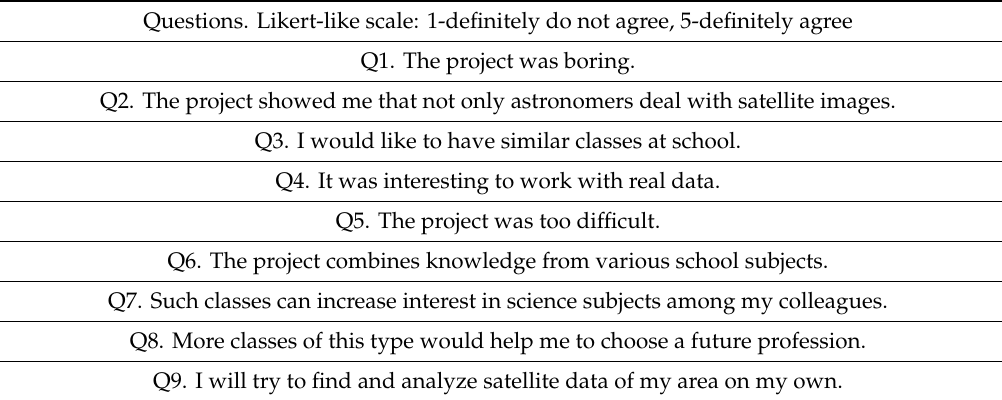
Table 1. Questions asked of students after participation in the